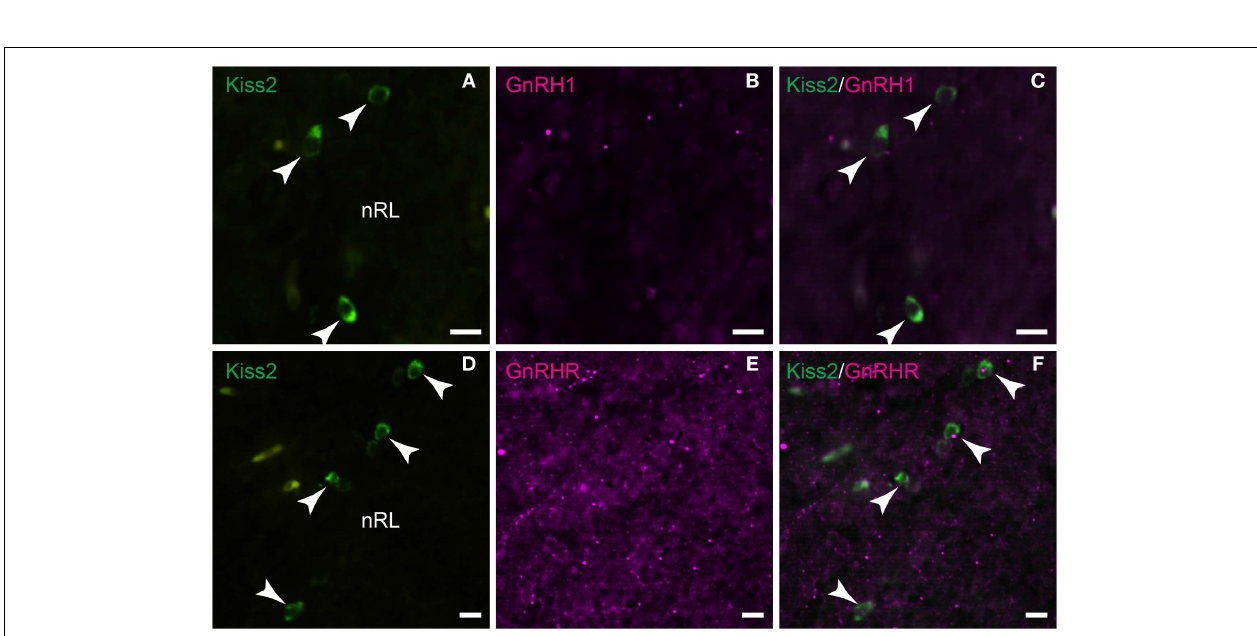
FIGURE 7 | Expression of thyroid hormone receptor (TR) types mRNA in laser-captured GnRH1, GnRH2, GnRH3, and kiss2 neurons . (A–H) Photomicrographs of GnRH1 (A,B) , GnRH2 (C,D) , GnRH3- immunoreactive (E,F), and DIG-labeled kiss2 (G,H) neurons before (A,C,E,G) , and after (B,D,F,H) laser-capture microdissection. Scale bars, 50 µ m. POA,